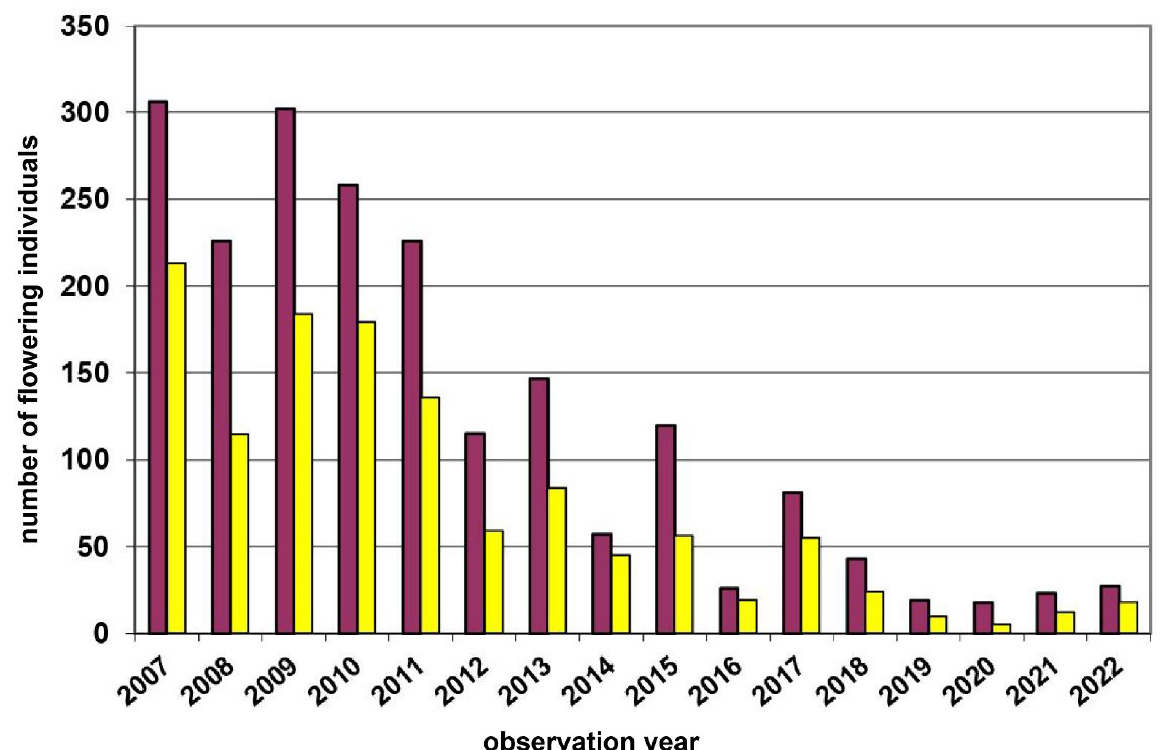
Figure 4. Population census (2007 – 2022) of the Dactylorhiza sambucina -population Wernhies in the Waldviertel region. Red columns = red-flowering plants and yellow columns = yellow-flowering plants.